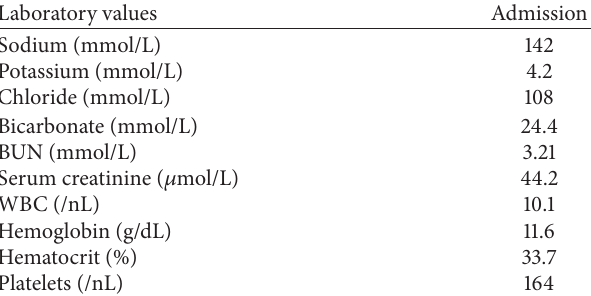
Table 1: Admission laboratory values.